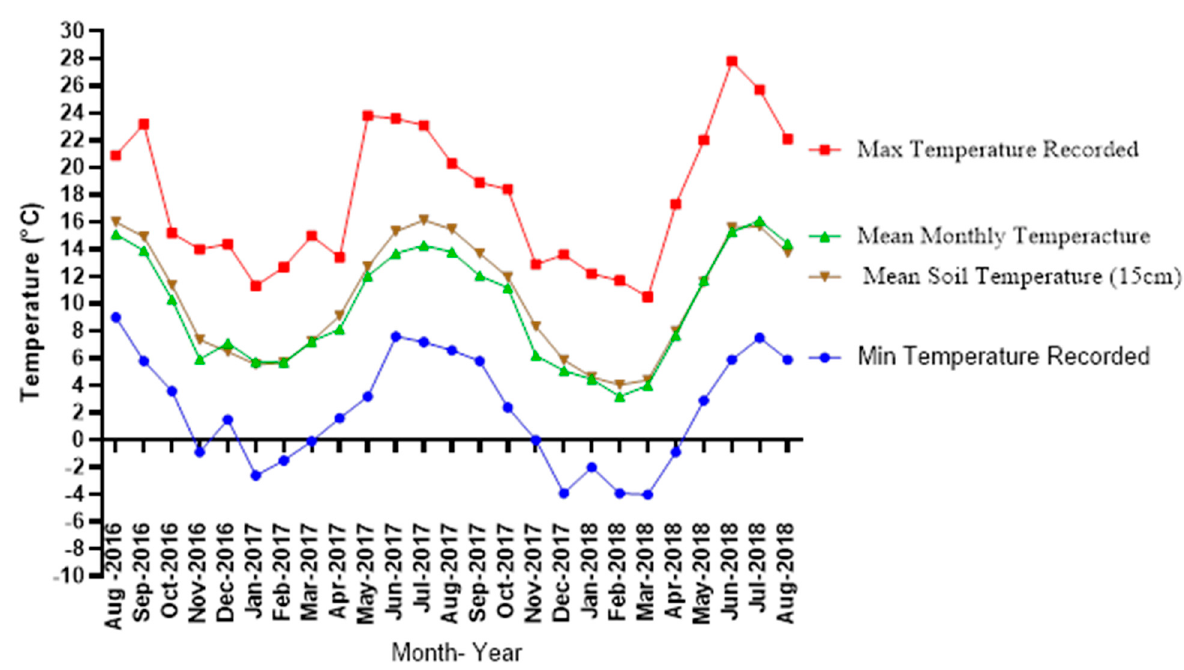
18 of 20 Figure A1. Monthly rainfall during the trial (mm).